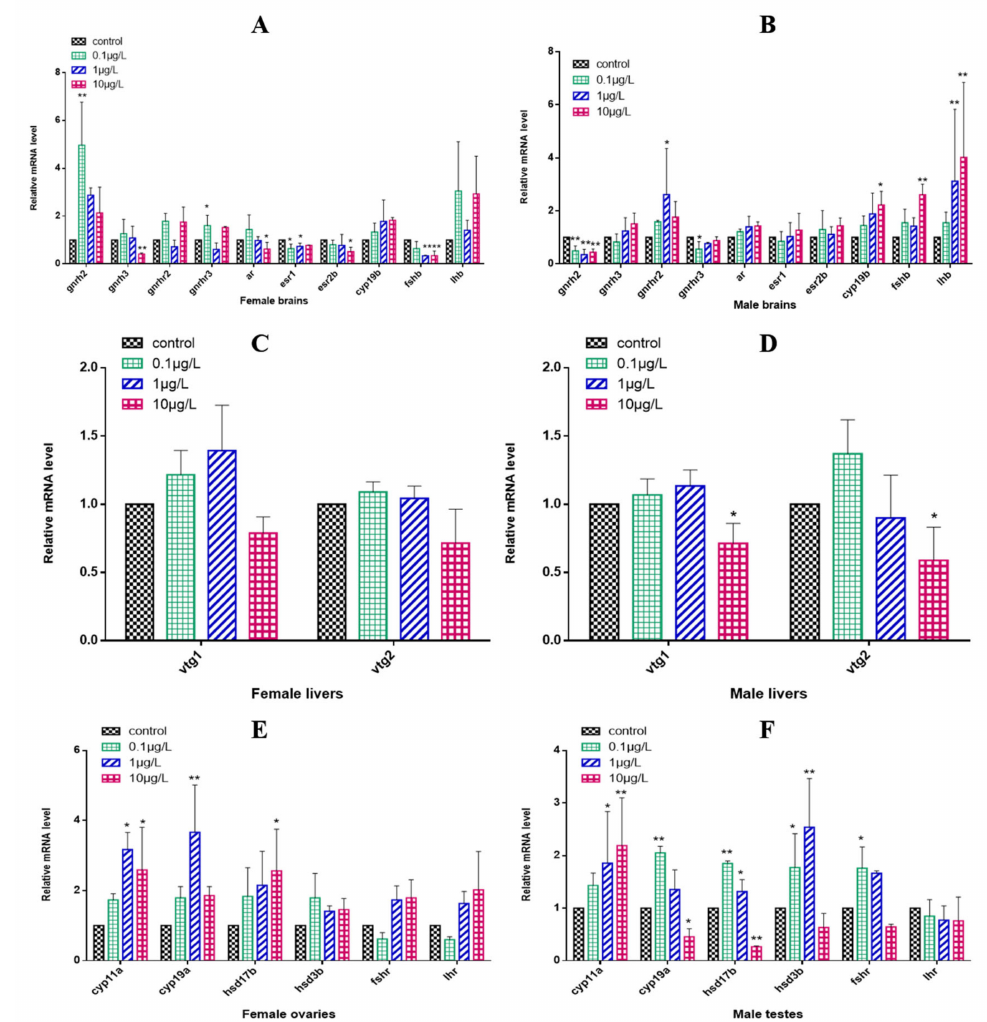
Figure 5. Transcription of HPGL axis-related genes in F0 zebrafish after 150 days of exposure to CyB. Females: ( A ) brain, ( C ) liver, ( E ) gonads; Males: ( B ) brain, ( D ) liver, ( F ) gonads. The results are presented as the mean ± SD of three replicates (* p < 0.05; ** p <